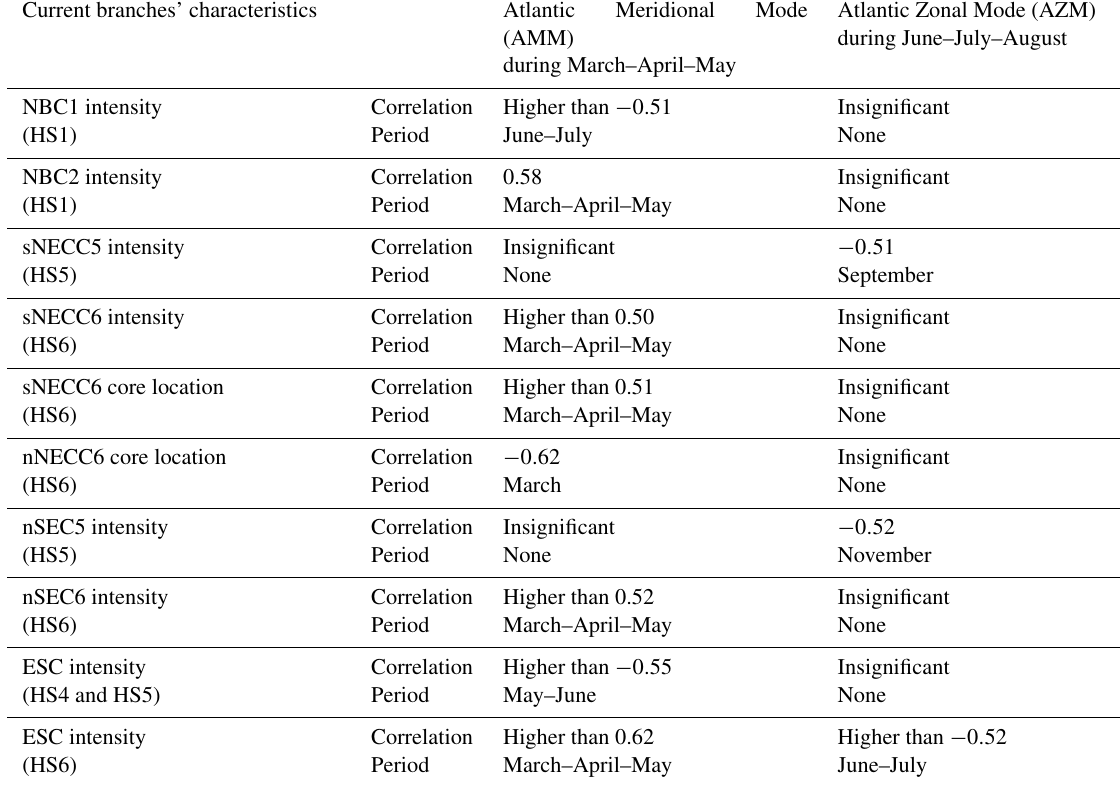
Table 2. Correlation values between the characteristics of the current branches and the Atlantic Meridional Mode and Atlantic Zonal Mode indices (AMM and AZM, respectively). The correlations that are found to be lower than 0.5 are labeled as “insignificant” over the whole time period (“none” is used to indicate when no month shows a strong correlation). The current branches analyzed are the NBC, sNECC, nSEC, and